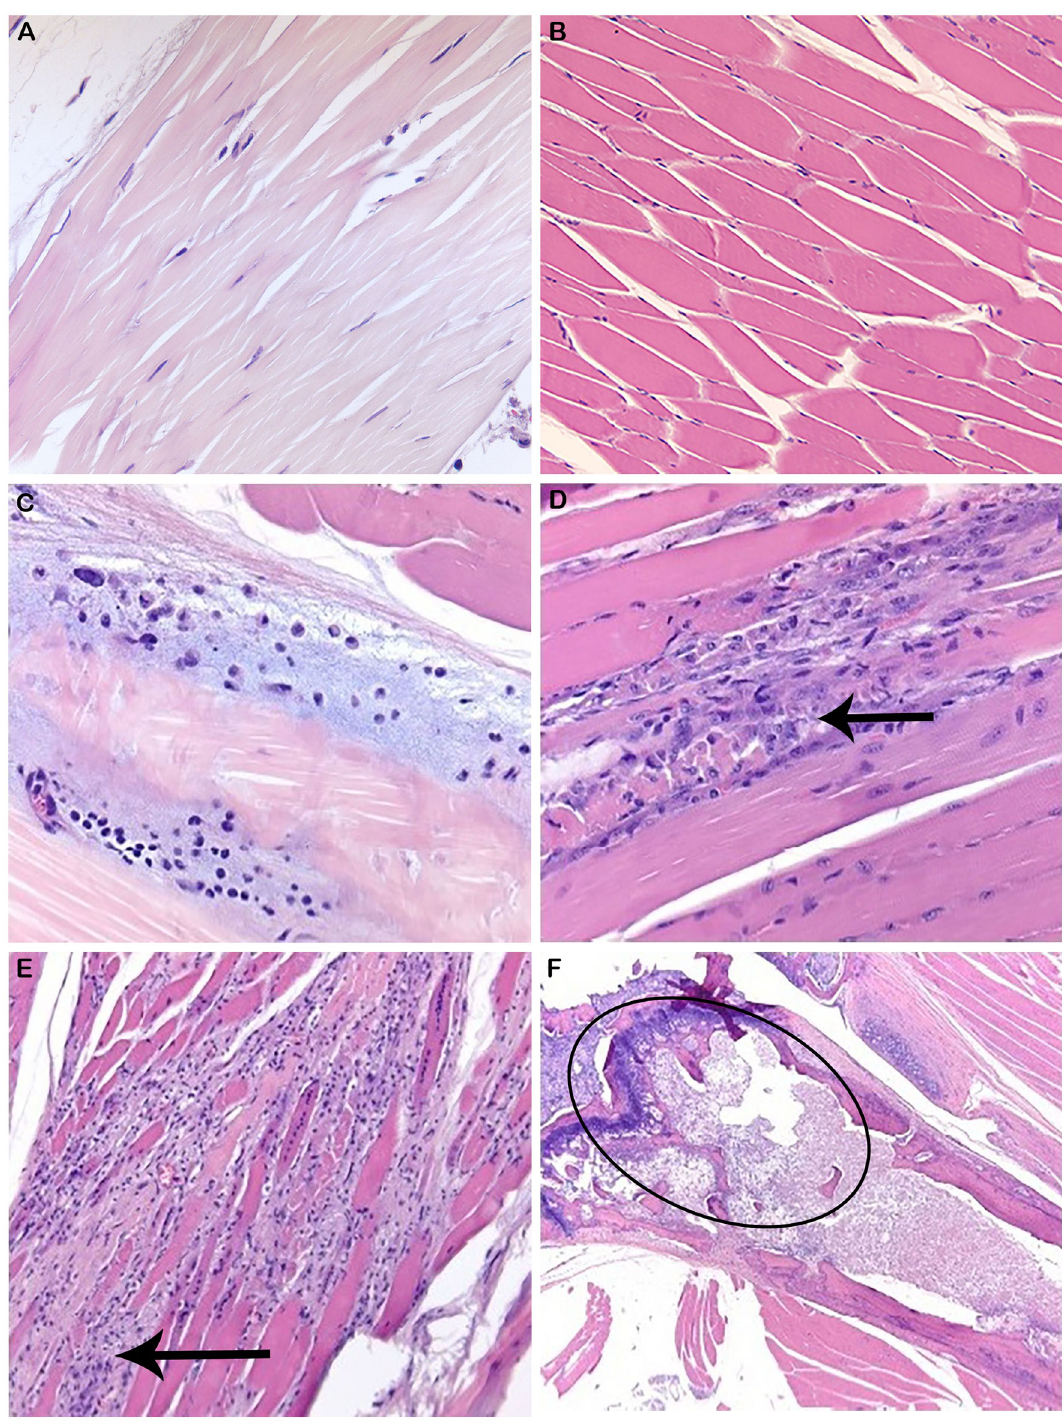
Fig 4. Histopathological lesions in CHIKV-infected Hu-NSG mouse joints and tissues. Histological staining of control and CHIKV-infected mouse tendon, muscle, and bone marrow from the region of the stifle. ( A ) Normal tendon (40X) from a control mouse. ( B ) Normal musculature (20X) from a control mouse. ( C ) Tendon histopathology showing tendonitis (Score = 1, 40X) in the tendons around the tarsus at 7 days post-infection via mosquito bite on the rear footpads. ( D ) Muscle histopathology indicating myositis of stifle musculature (black arrows) at day 14 post-infection (Score = 2, 40X) via mosquito bite of the rear footpads. ( E ) Muscle histopathology indicating myositis of paw/digit musculature (black arrows) at day 25 post-infection (Score = 3, 20X) via